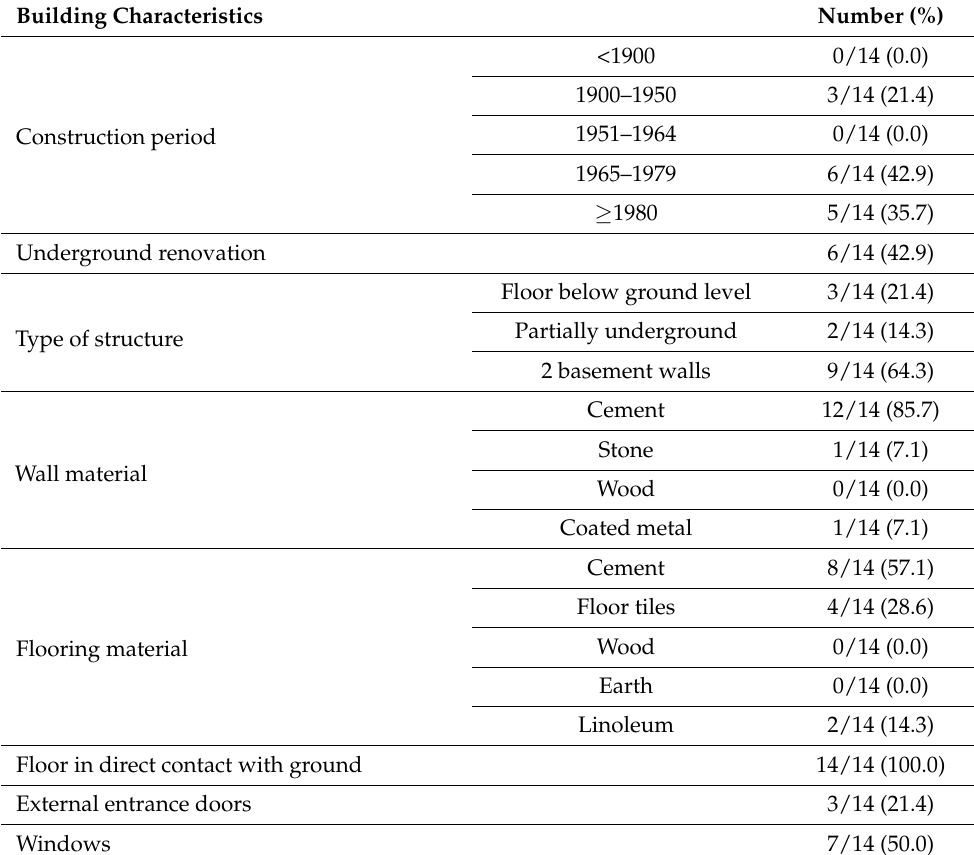
Table 1. Radon inspections in 14 rooms of 7 different hospital pavilions. Descriptive